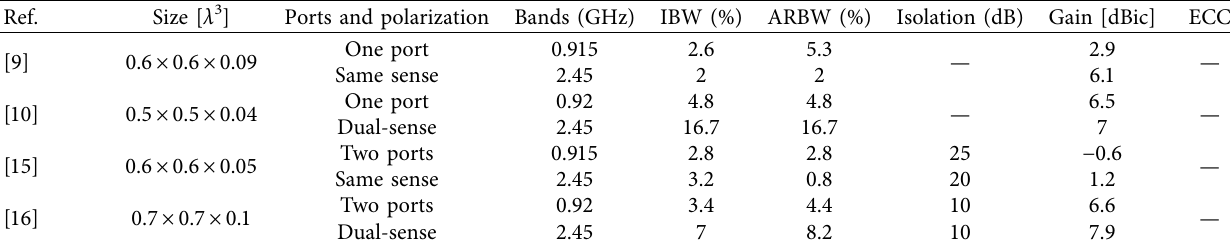
Table 2: Performance comparison with other proposed dual-band multiport CP antenna systems.